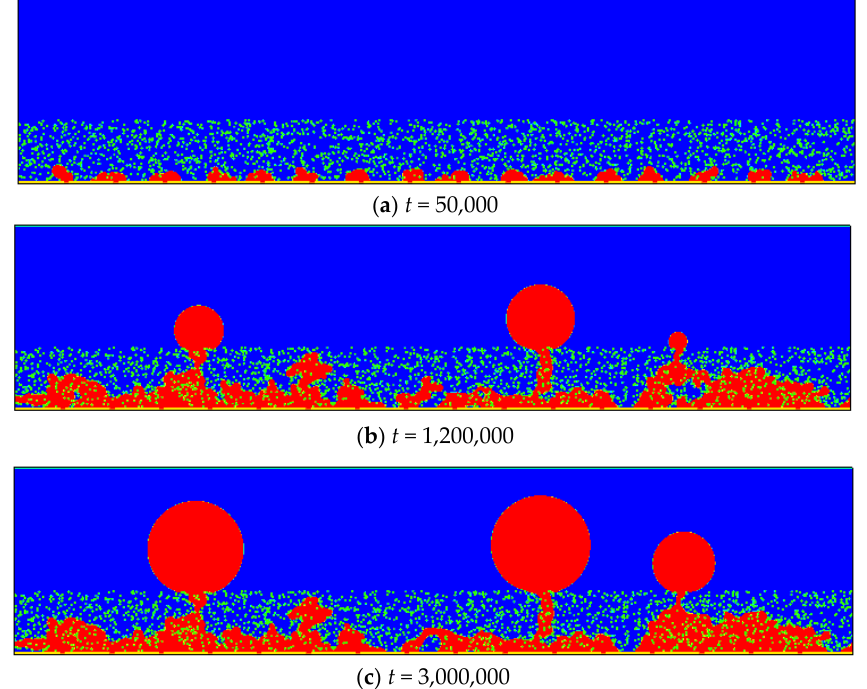
Figure 10. Time evolutions of liquid water distribution in the domain with 16 fractures.